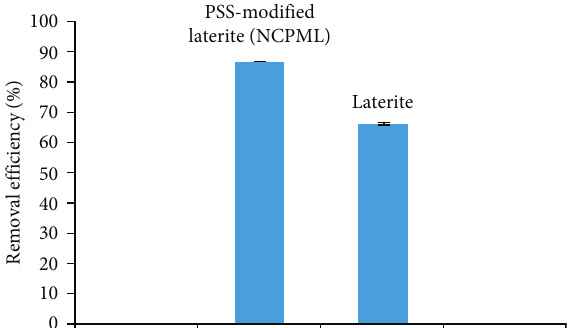
Figure 11: Removal efficiency of TC onto laterite with and without modification by PSS. Error bars show standard deviation of three